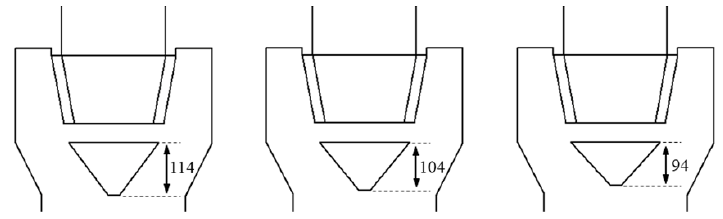
Figure 15. Structure of the diversion cone at different heights.